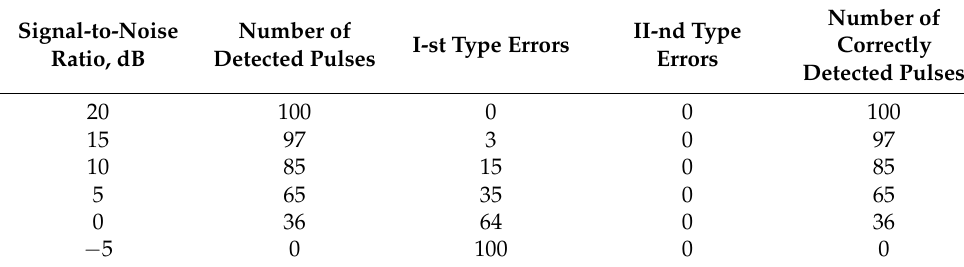
Table 1. Test results for the pulse detection